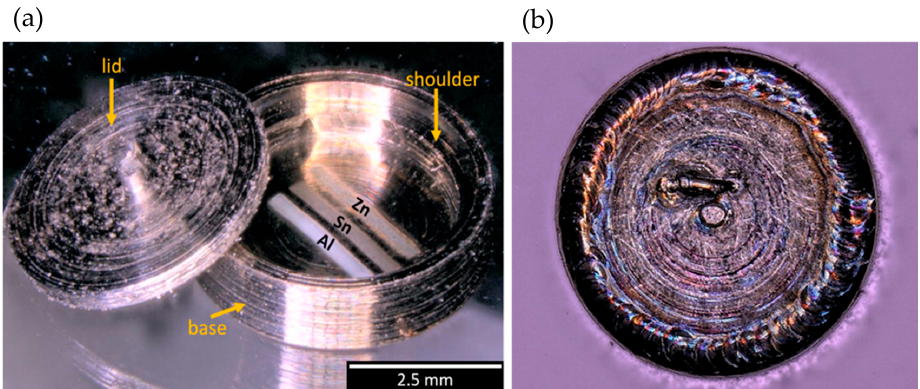
Figure 3. Inert atmosphere encapsulation design for AM melt wires. ( a ) Melt wire container ready to be sealed with AM melt wires on the base of the encapsulation package, and ( b ) a top-view of the sealed capsule.